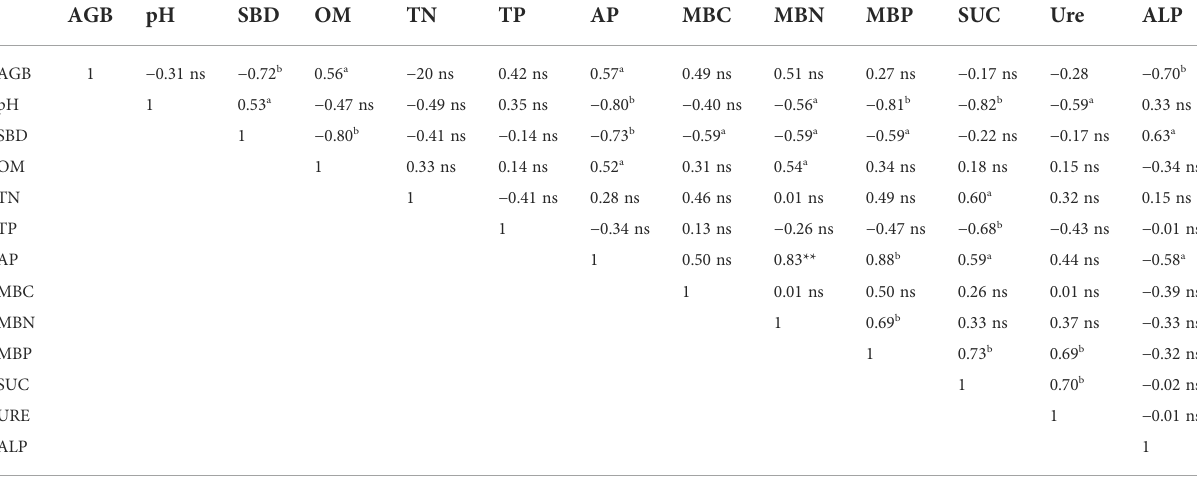
TABLE 2 Correlation coef fi cients between aboveground biomass and soil properties for all treatments.